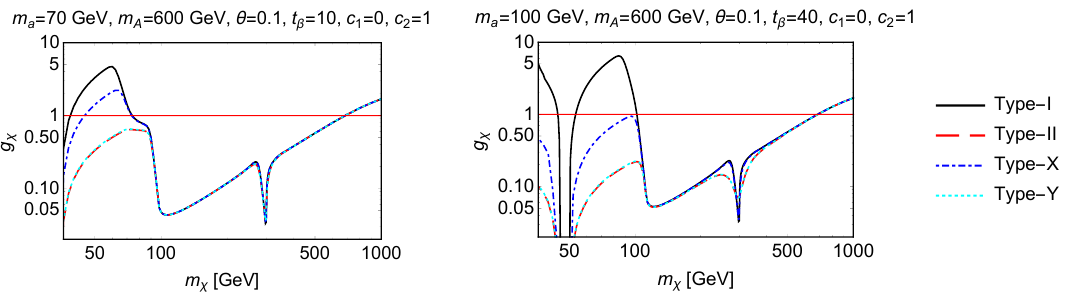
Figure 5 . The DM-pseudoscalar coupling g (cid:31) as a function of m (cid:31) . The left panel shows g (cid:31) for m a = 70 GeV and t (cid:12) = 10, and the right for m a = 100 GeV and t (cid:12) = 40. The other parameters are m A = 600 GeV, (cid:18) = 0 : 1, c 1 = 0, c 2 = 1 for both of the panels. The black solid, red dashed, blue dot-dashed, and cyan dotted lines show the type-I, II, X, and Y, respectively. The red horizontal line indicates g (cid:31) = 1. The coupling of the type-Y turns out to be almost the same result as that of the